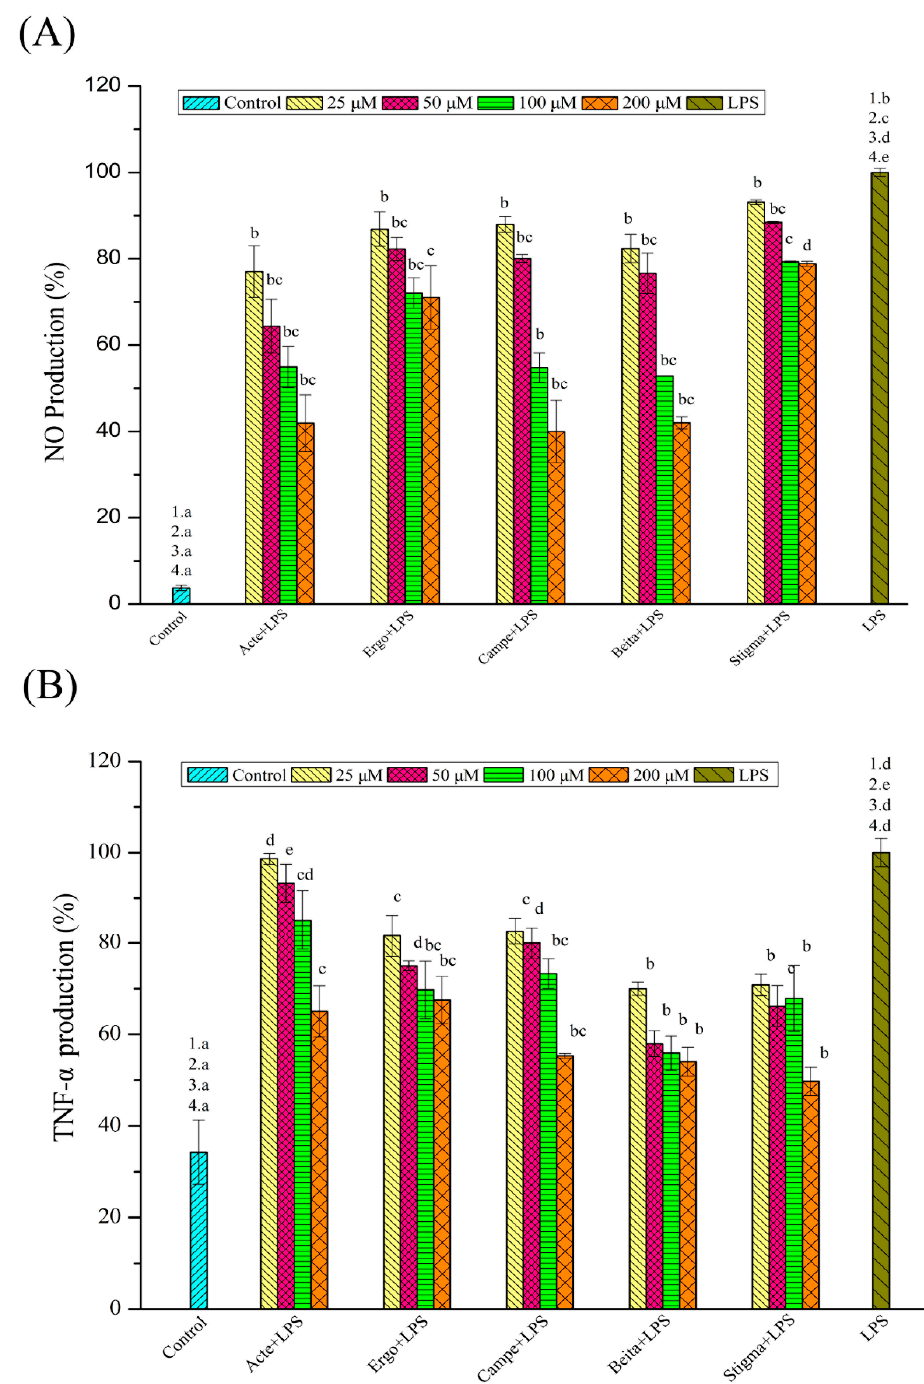
Figure 4. ( A ) Effects of phytosterols on the release of nitric oxide (NO) in LPS-stimulated inflammatory cell models ( n = 6). Acte (ergosterol acetate). ( B ) Effects of phytosterol compounds on LPS-stimulated inflammatory cell model secreting cytokines tumor necrosis factor- α TNF- α ( n = 6). Ergo (ergosterol); Campe (campesterol); Beita ( β -sitosterol); Stigma (stigmasterol). The data are expressed as means ± SEM; different superscript letters for columns at the same concentration denote a significant difference ( p < 0.05); the numbers describe that the control/model group was compared with the experimental group at the concentrations of 25 (1), 50 (2), 100 (3), and 200 (4) μ M.